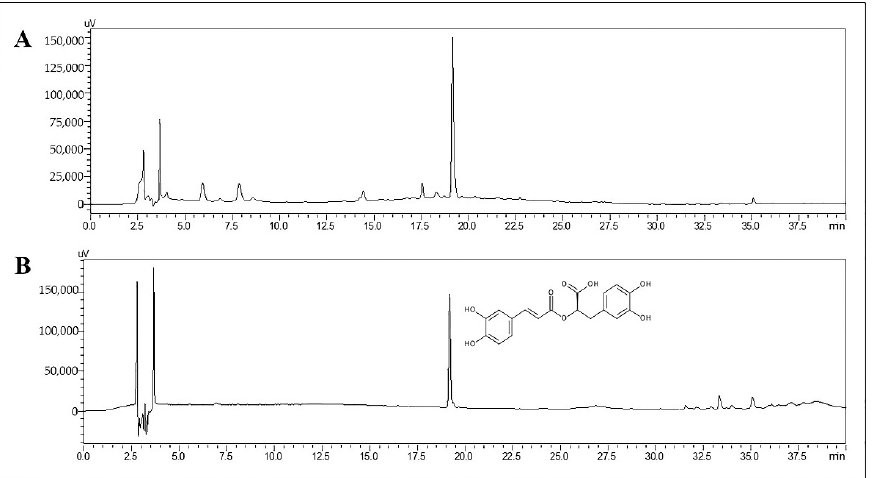
Figure 1. Representative HPLC chromatogram of TL extract ( A ) and RA ( B ).